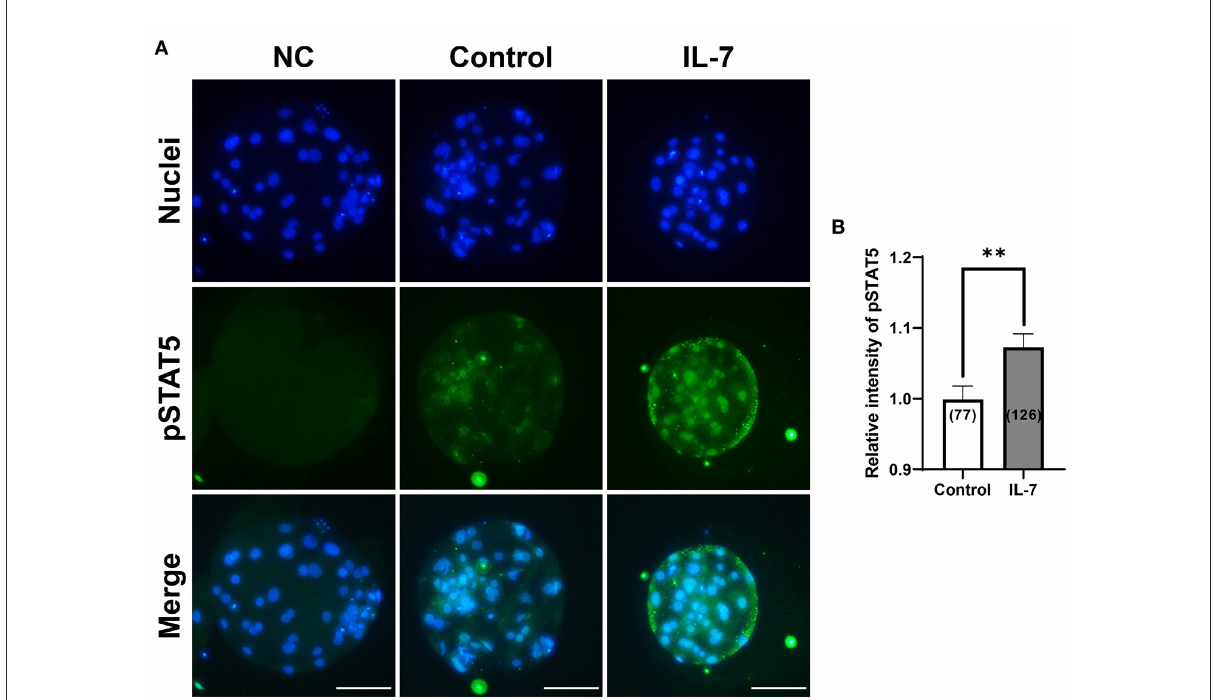
FIGURE7 Effect of IL-7 supplementation during IVC on phosphorylated STAT5 (pSTAT5) expression of blastocysts after PA. (A) Representative immunofluorescence images (200 × ) of porcine parthenote blastocysts labeled with Hoechst 33342 (Total nuclei, blue) and pSTAT5 (green) after IVC. NC, negative control. Scale bar: 100 µ m. (B) Quantification of the relative intensity of pSTAT5 in the indicated groups. The number of blastocysts examined in each experimental group is shown in parentheses. Asterisks indicate statistical significance (** p < 0.01). For the graph, the values represent the mean ± SEM. The experiment was replicated four